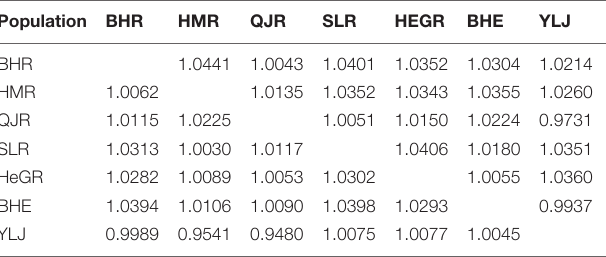
TABLE 4 | Gene flow (Nm) analysis of G. przewalskii populations by two mitochondrial